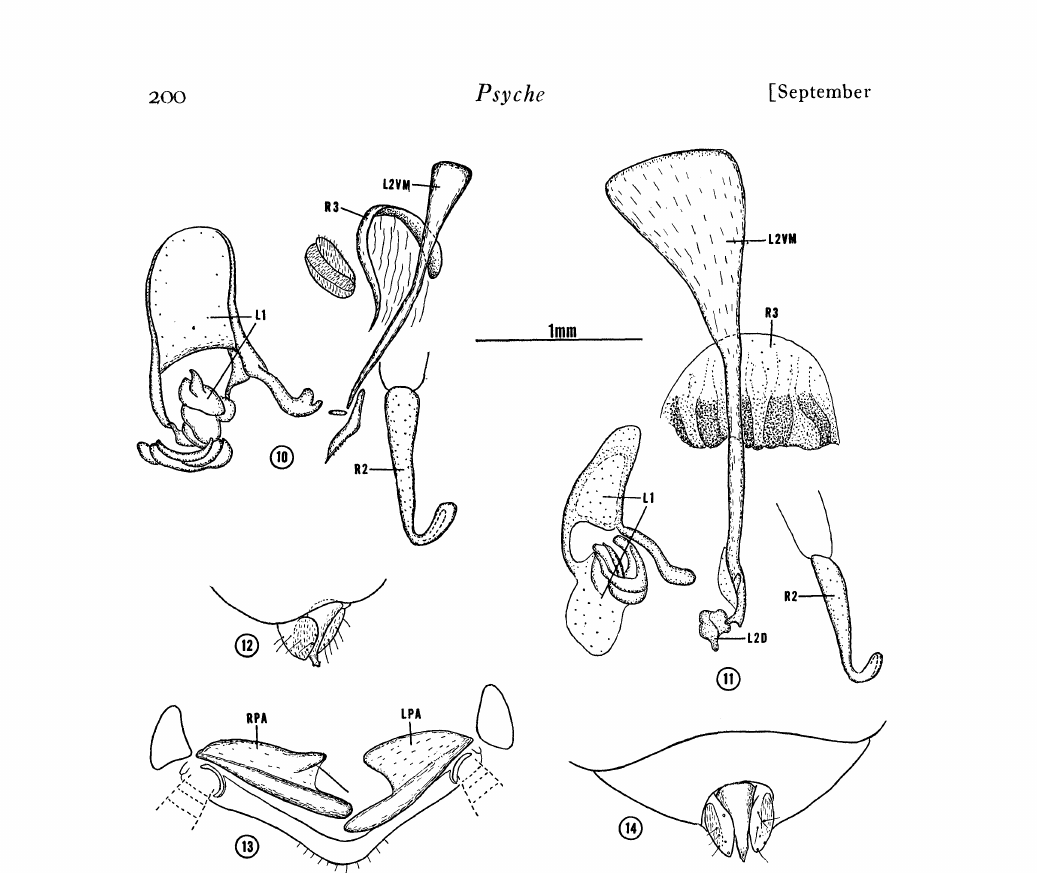
Figs. 10-14. Male genitalia of Igmoblatta and Isoldaia (All drawn from KOH preparations) 10. lgmoblatta thaxteri (Hebard). Male from Natiek culture originating in Buenos Aires, Argentina. Dorsal view of phallomeres. 11-14. Isoldaia insularis (R. S. Albuquerque and Gurney), male holotype. 11. Dorsal view of phallomeres. 12. Ventrolateral view of apical portion of subgenital plate. 13. Ventral view of paraprocts and associated struc- tures. 14.. Ventral view of subgenital